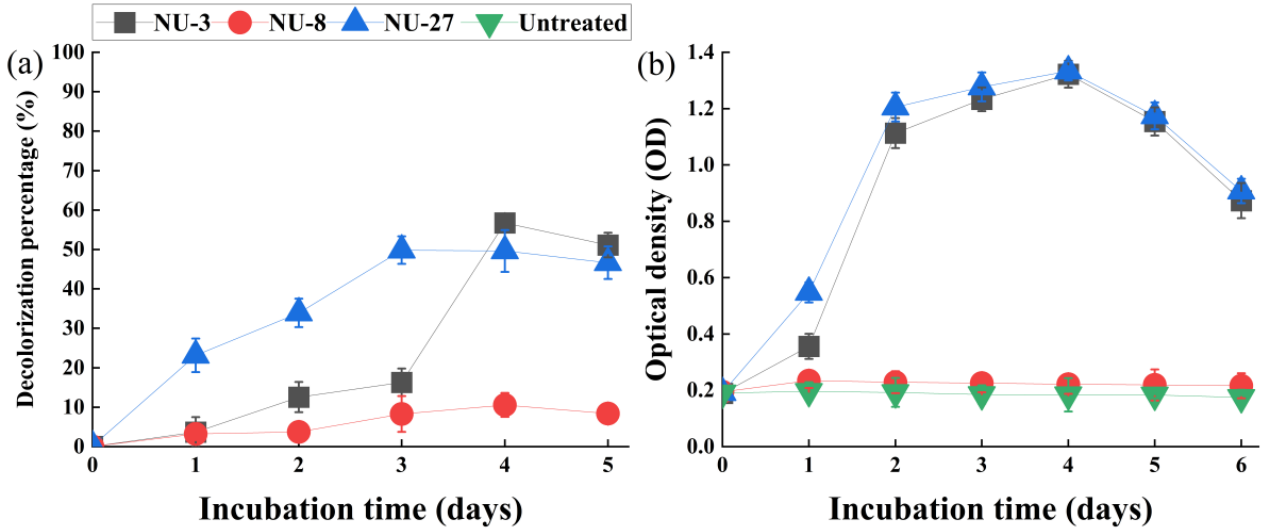
Figure 3. Decolorization percentage in 10-fold diluted anaerobic digestion piggery effluent (ADPE) pretreated by three isolated fungi (NU-3, NU-8, and NU-27) ( a ), and growth curves of NCU-39 in the ADPEs with and without fungal pretreatments ( b ). Error bars represent standard deviations ( n = 3).